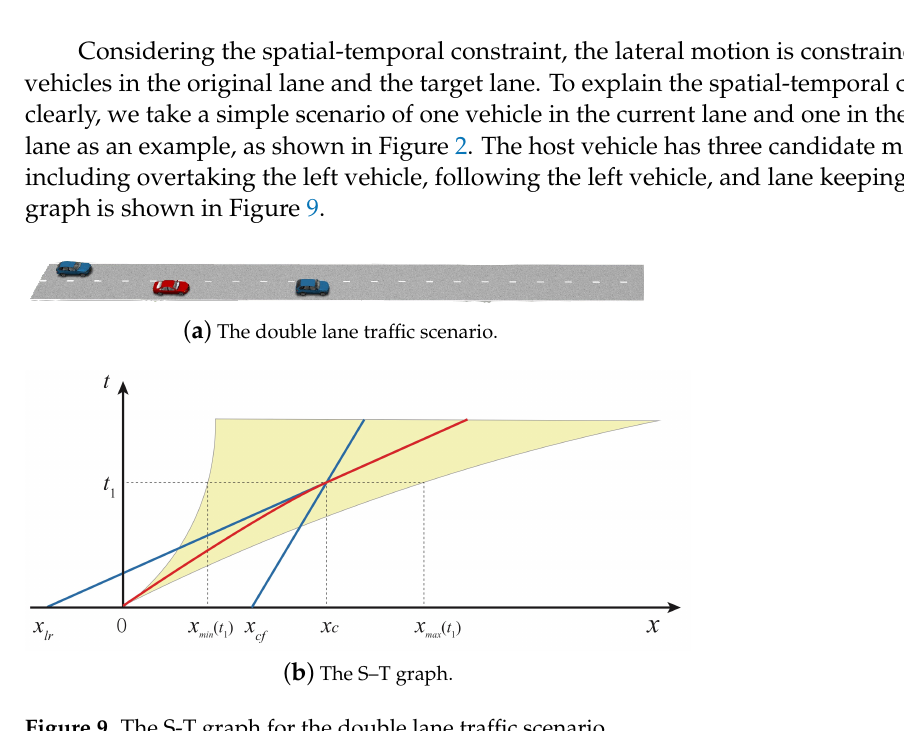
Figure 9. The S-T graph for the double lane traffic